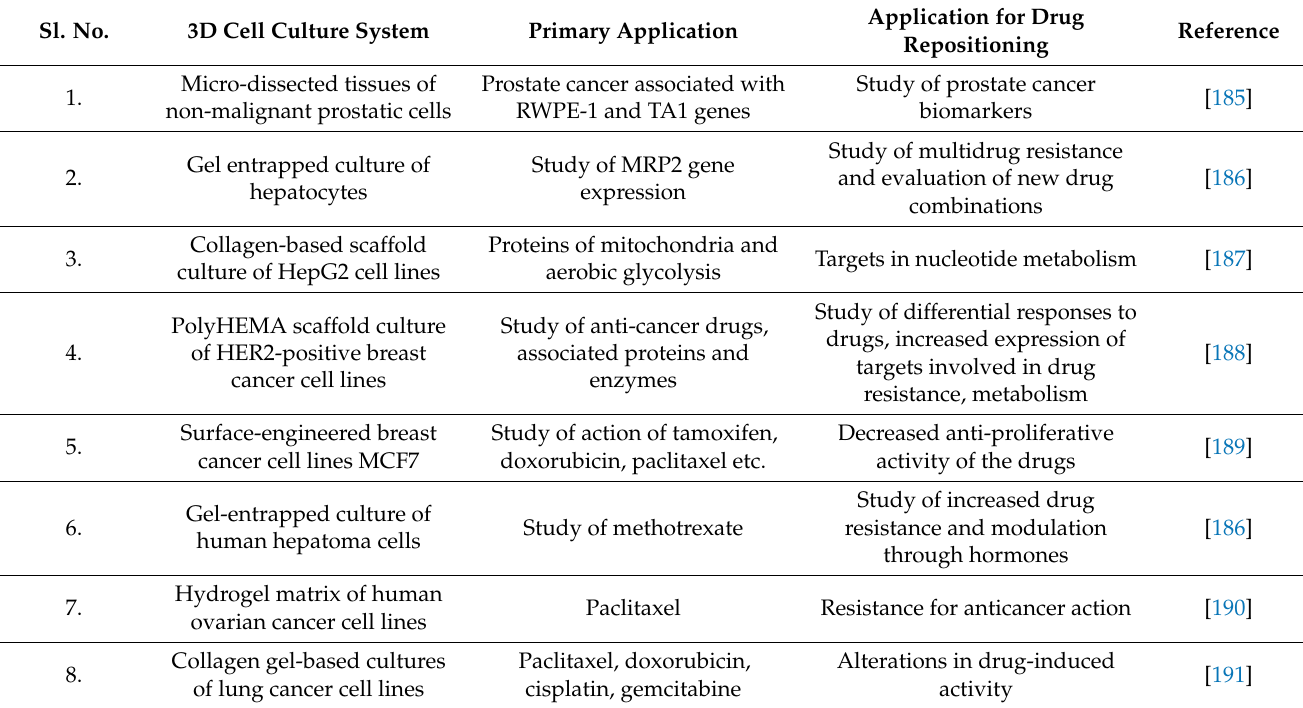
Table 7. Potential role of 3D cell culture models in drug